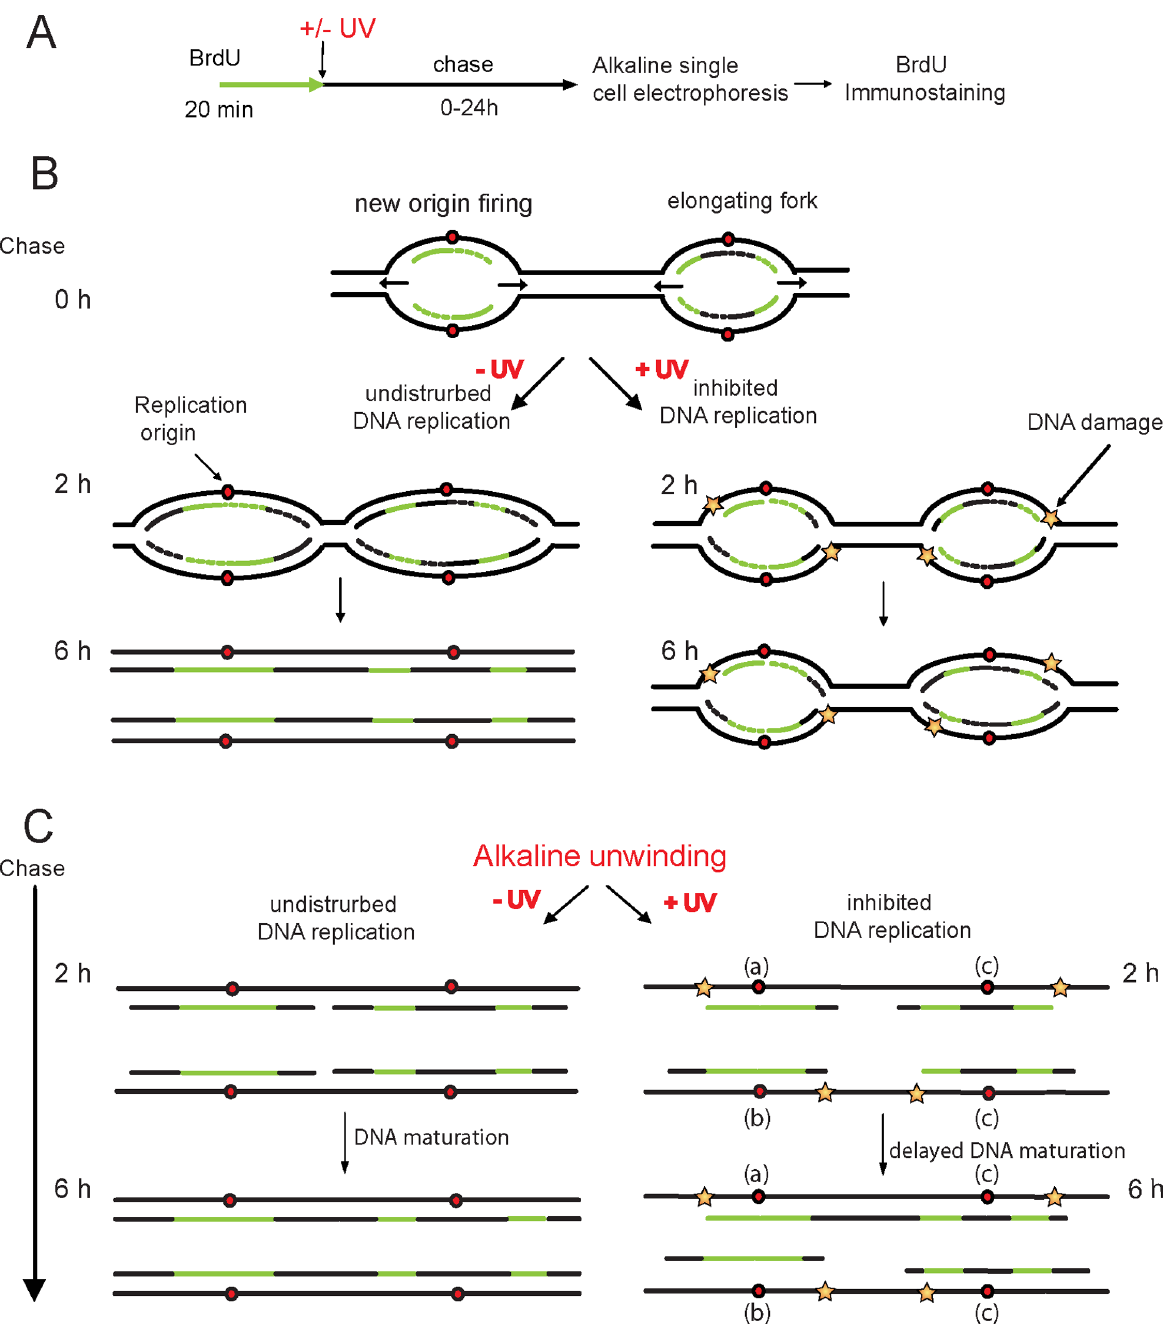
Figure 1. Main principle of the alkaline BrdU comet PRR assay. ( A ) Experimental setup. ( B ) Chematic illustration of neighbouring origins and bidirectional way of replication fork movement. BrdU incorporates into newly replicated DNA strands during short pulse labelling. As replication progresses, the labelled strands move apart from the replication fork during the chase period and are incorporated into high molecular weight DNA. In the untreated cells (-UV) the discontinuities of DNA strands are abolished gradually by ligation of DNA strands elongated from neighbouring origins in a process called DNA maturation. In the presence of DNA adducts caused by UV irradiation ( + UV), replication fork movement is inhibited and the nascent DNA remains discontinuous for a longer time. ( C ) At early stages of replication of an undamaged template, the short stretches of newly replicated DNA can be separated from the template strand by alkaline unwinding and visualised as comet tail DNA after short alkaline electrophoresis followed by immunostaining with anti-BrdU antibody. Two different types of events are presented as examples with neighbouring replication origins: labelling of new origin firing and an elongating fork. As the replication fork elongates on undamaged template and DNA maturation is completed by the ligation step, the DNA becomes a continuous, high molecular weight molecule, forming the comet head. On damaged templates DNA replication is inhibited and the DNA remains fragmented, the labelled fragments migrate into the comet tail and can be detected as low molecular weight fragments even at late time points. Examples of detectable labelled fragments are shown as (a) termination of a new origin firing, (b) termination of elongation and (c) inhibition of elongation.